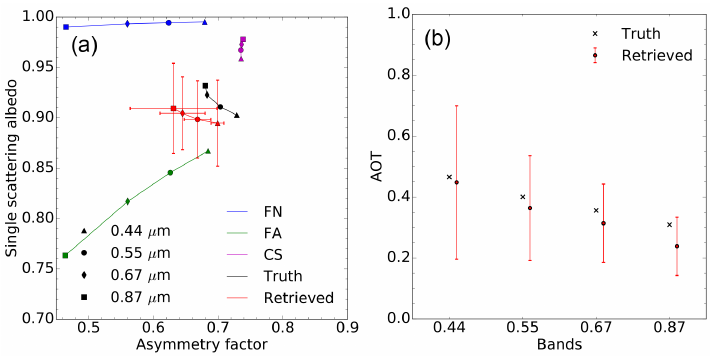
Figure 10. Same as Fig. 5 but for experiment F21.